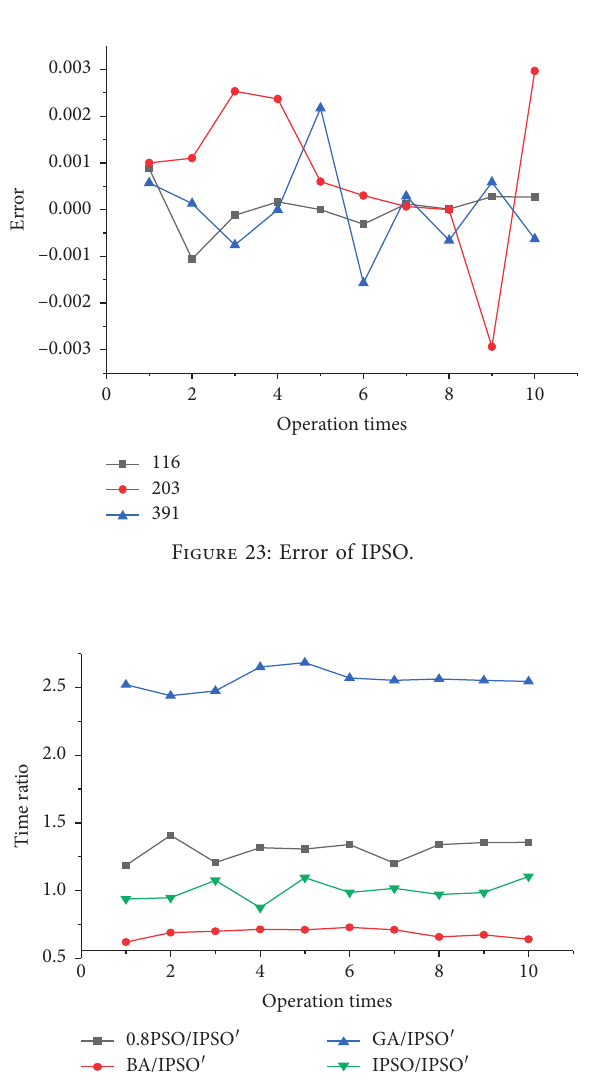
Figure 24: Ratios of running time of the four